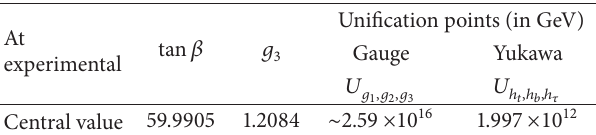
Table 4: Approximate unification points for gauge couplings and Yukawa couplings for 𝑔 DR 3 = 1 . 2084 and 𝑚 𝑠 = 𝑚 𝑡 .